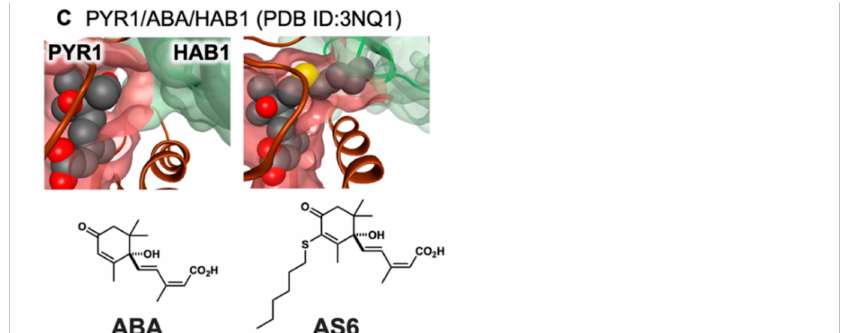
Figure 2. Structure-guided antagonist design. ( A ) Auxinole is superimposed onto TIR1 (blue)-AUX / IAA (purple) coreceptor (PDB:2P1Q), ( B ) COR-MO is superimposed onto COI1 (green)-JAZ1 (orange) coreceptor (PDB:3OGM), and ( C ) AS6 is superimposed for PYR1 (brown)-HAB1 (green) coreceptor (PDB: 3QN1 and 3WG8). The structures were modeled and rendered by MOE (Molecular